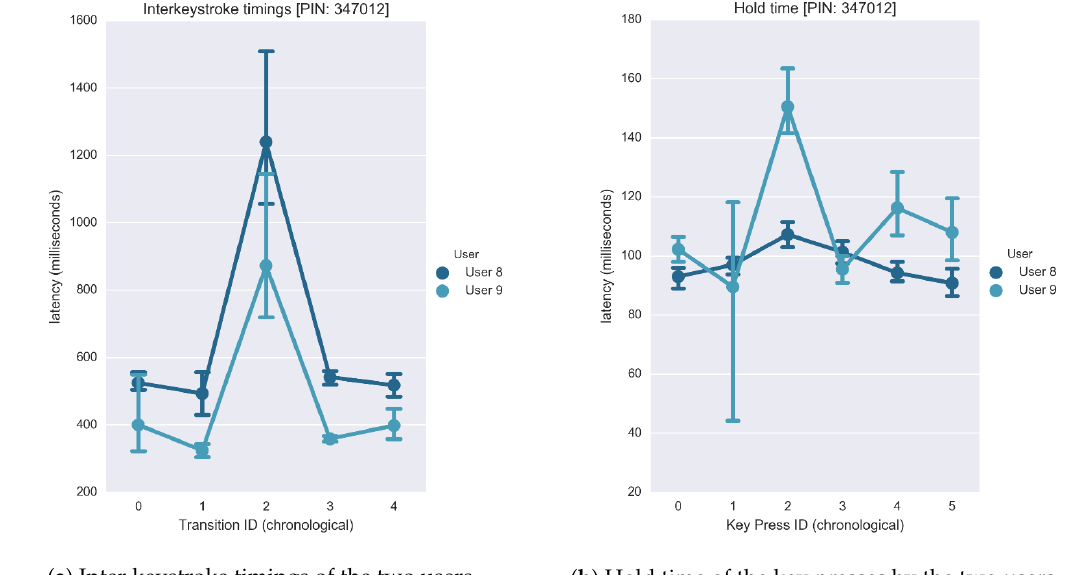
Figure 15. Inter-keystroke Timings and Hold Variation of the two user